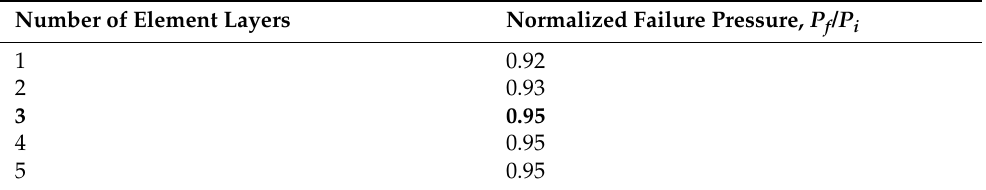
Table 4. Convergence test results for the optimal number of mesh layers at the defect region for Test Model